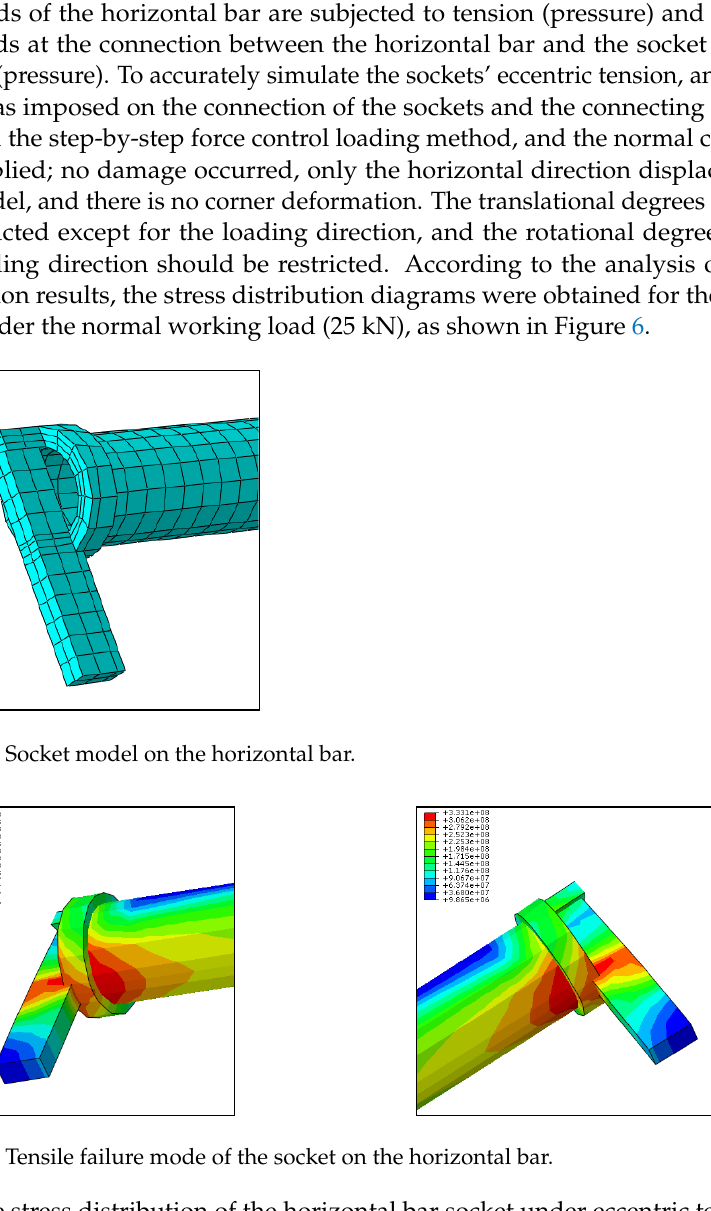
Figure 4. Graphs of the eccentric tensile capacity of sockets on horizontal bars.